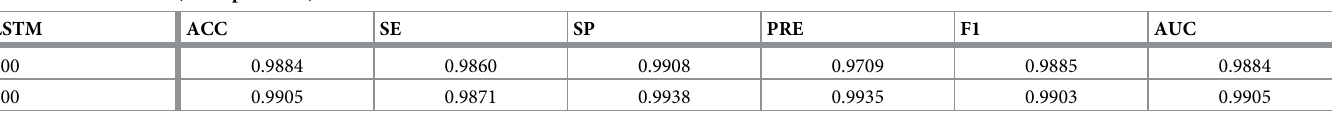
Table 8. LSTM results (2 nd experiment).